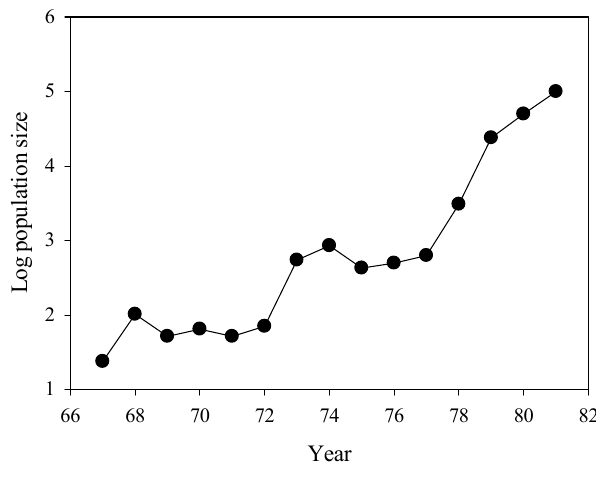
Figure 1. Increase in number of Honckenya peploides plants on Surtsey between the years 1967 and 1981 (after Fridriksson,